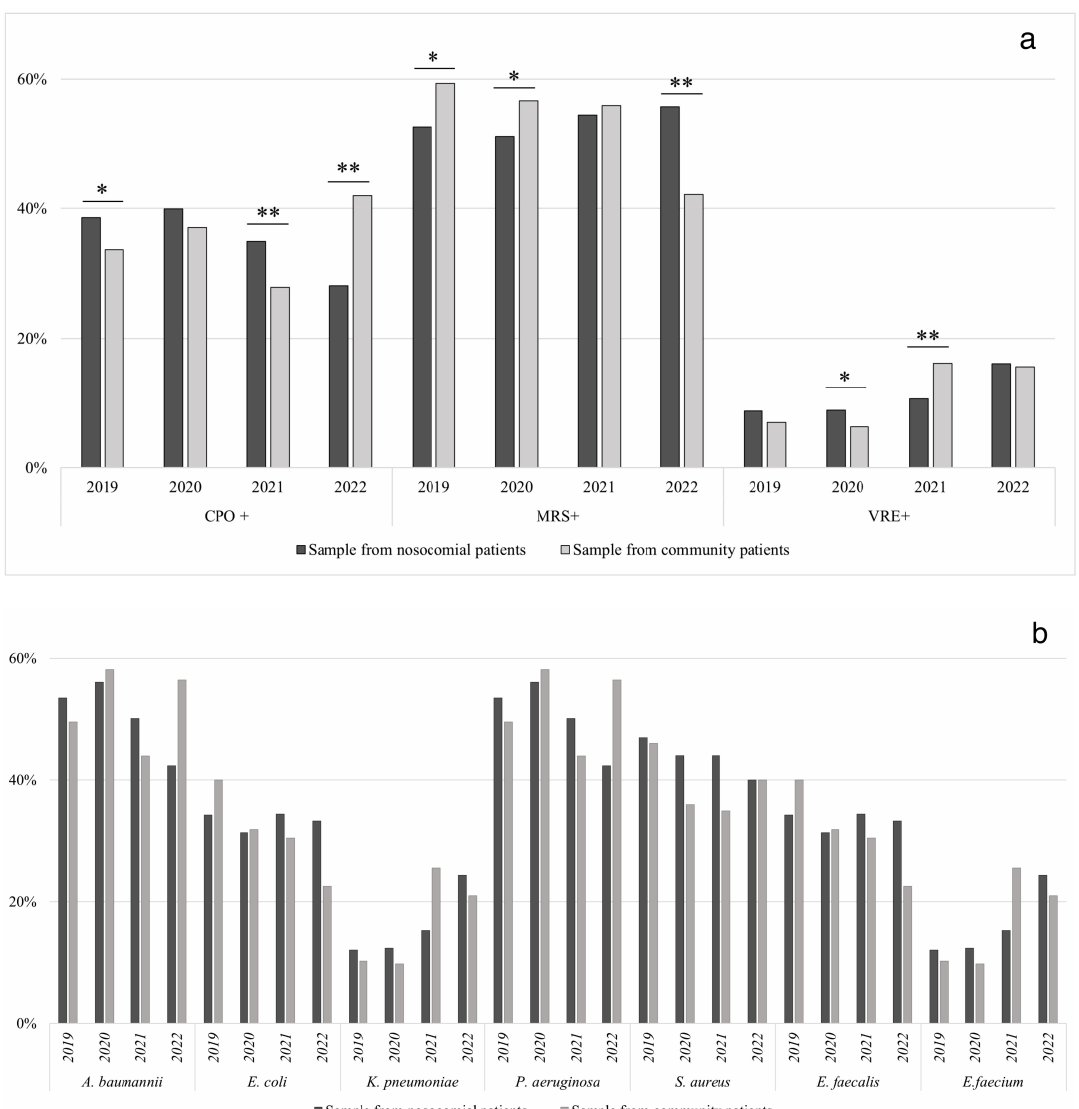
Figure 3. Data of resistance detection rate of samples from nosocomial patients and community patients versus CPO, MRS and VRE bacteria (panel ( a )) and versus single pathogens (panel ( b )) [“*” = p < 0,05; “**” = p < 0,001]